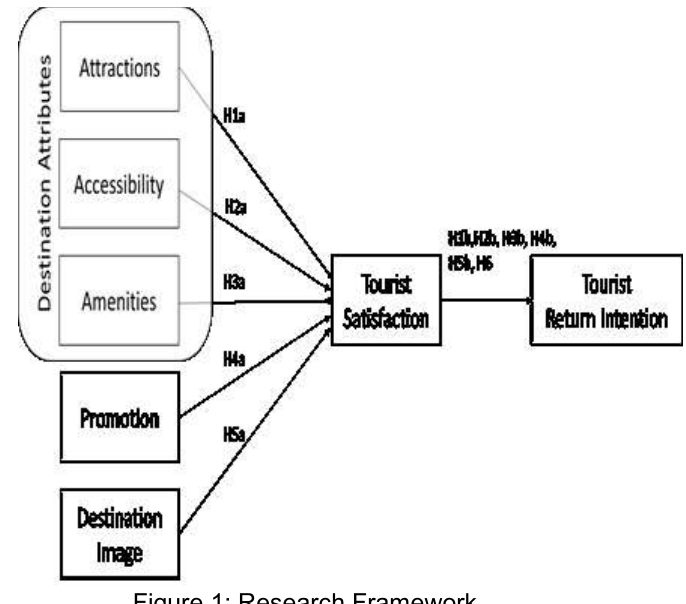
Figure 1: Research Framework